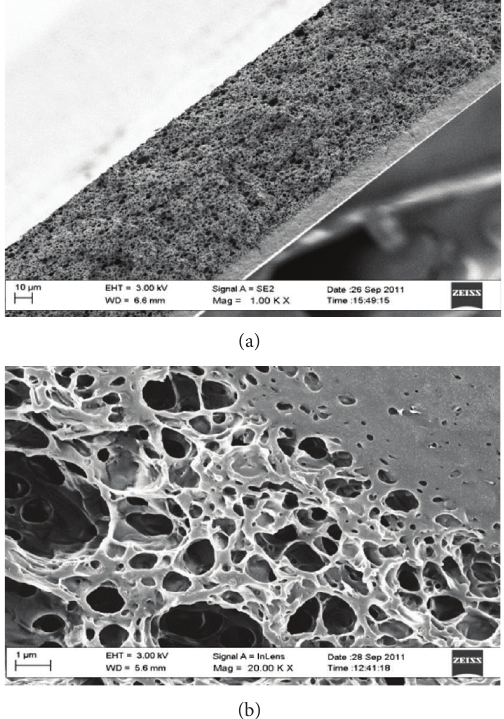
Figure 3: SEM image taken by in-lens detection mode of a bilayer PHB film combining a dense PHB layer with a porous layer made with 10% of water in the emulsion template showing (a) the whole cross section (scale bar 10 𝜇 m and magnification × 1k) and (b) the interface between the two layers at a higher magnification (scale bar 1 𝜇 m and magnification × 20 k).